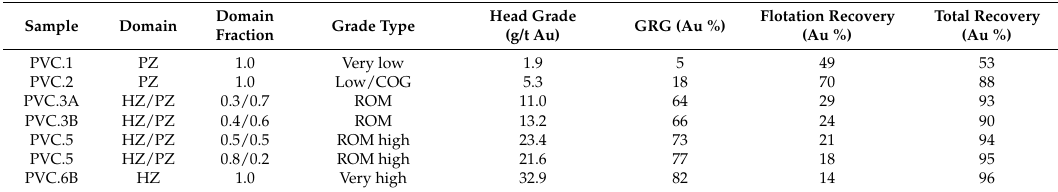
Table 20. Summary of pilot plant testwork results.